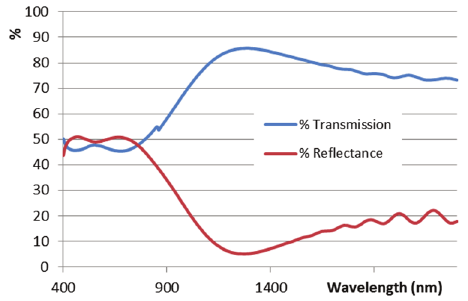
Fig. 10. Transmission and reflection properties of the EBS2 semi-perme- able mirror [10]